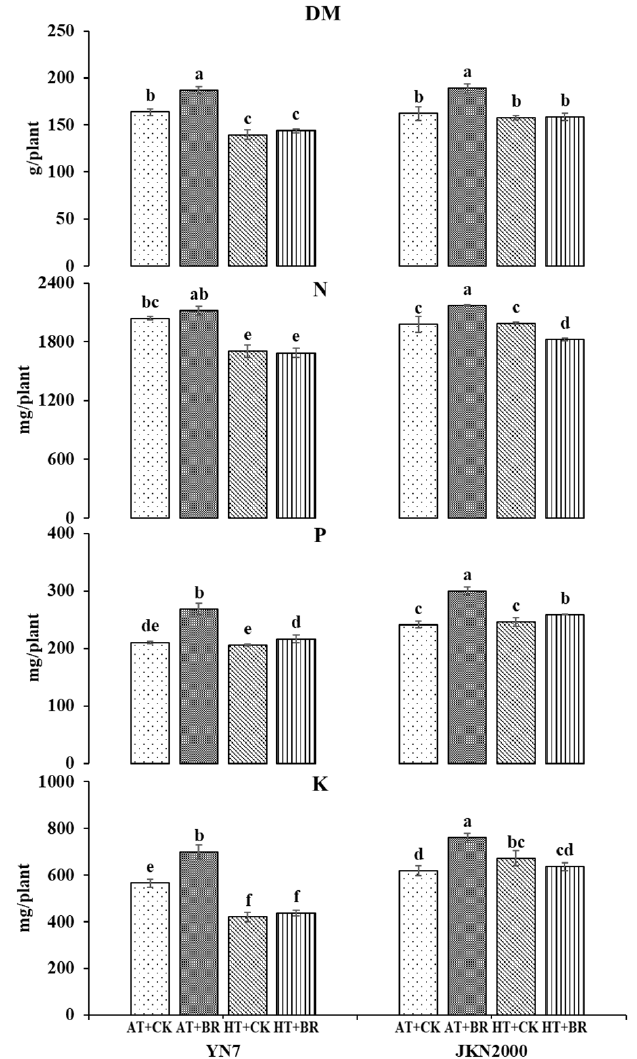
Figure 2. Effects of exogenous BR application at the silking stage on the DM and nutrients accumula- tion at maturity of waxy maize under post-silking ambient and high temperatures. YN7, Yunuo7; JKN2000, Jingkenuo2000; AT, ambient temperature; HT, high temperature; CK, control, plants sprayed with 100 mL water; BR, brassinolide, plants sprayed with 100 mL 0.25 mg/L BR. Within columns, those followed by the same letters are not significantly different ( p <